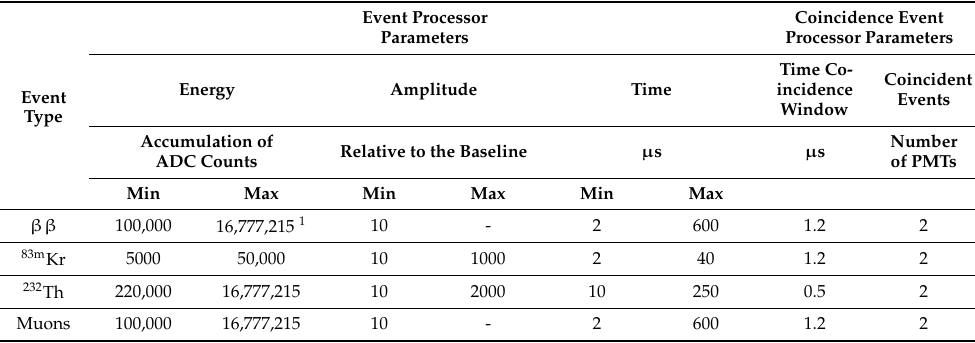
Table 1. Event detection parameters applied to detect some of the calibration sources, muons and beta decay physics during RUN V. Same configuration applied in the event processor for all the PMT sensors. Circular Buffer size of 1600 µ s and pre-trigger of 800 µ